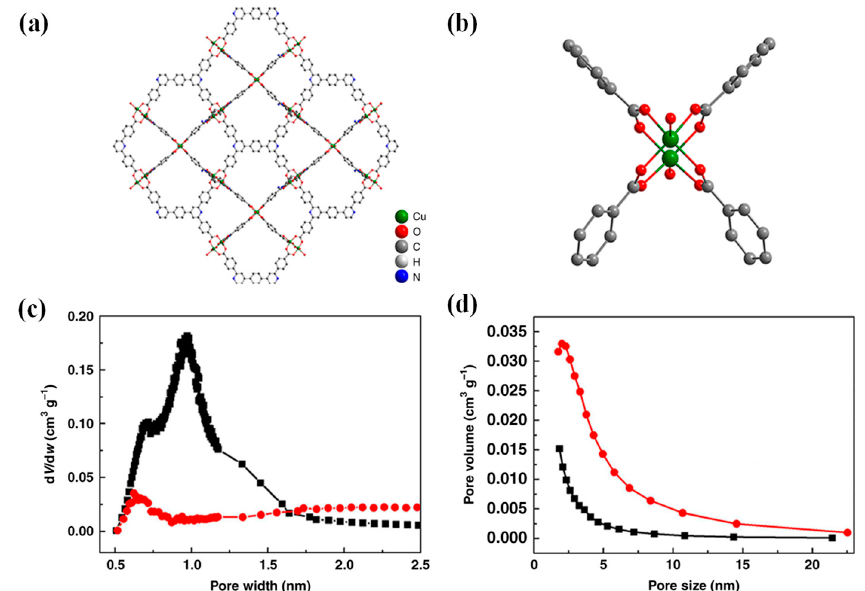
Figure 8. ( a,b ) Views of the crystal structure of [Cu 2 (L)] (CCDC1531622); ( c,d ) micropore and mesopore size distribution. (Cu 2 (L) − t (black lines) and Cu 2 (L) − e (red lines)) [69]. Reprinted with permission from Ref. [69]. Copyright 2020 Copyright Nature (Oxford, England). Table 3. Summary of catalytic performance of PCP catalysts in CO 2 electroreduction.